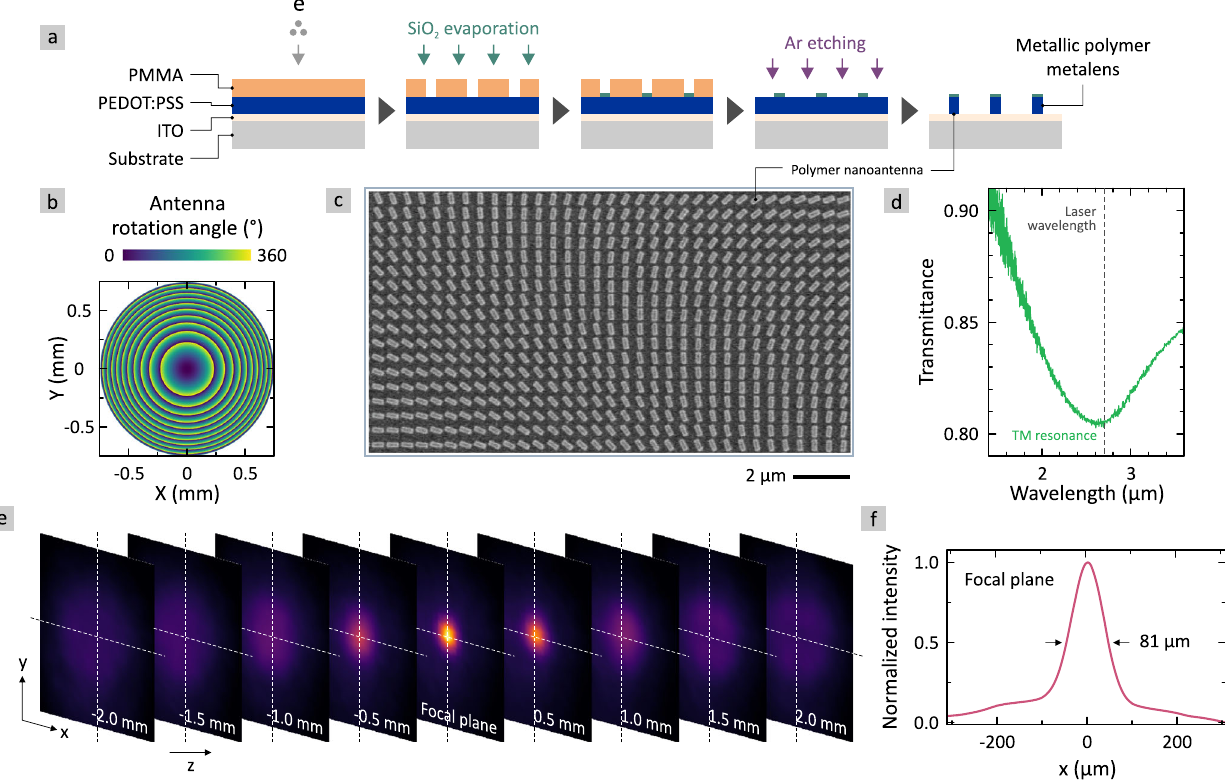
Fig. 2 | Fabrication and static characterizationofa metallicpolymer metalens. a Fabrication route to obtain the metallic polymer metalens comprisingplasmonic nanoantennas.Detailsaregiveninthemaintext. b 2Dmapofnanoantennarotation angle to obtain a quadratic phase pro fi le of a metalens with focal length f =5mm, diameter of 1.5mm, numerical aperture of 0.15, and illumination wavelength λ =2.65 µ m. c SEM image of a sub-area of the metallic polymer metalens showing